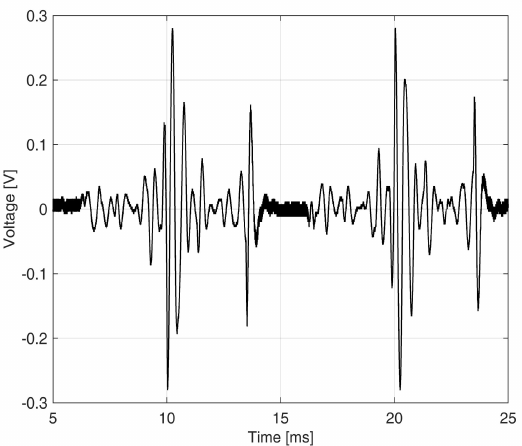
Figure 2. Typical time-domain waveform of an SMPS at the high-pass filtered LISN output measured as DSO input signal y 1